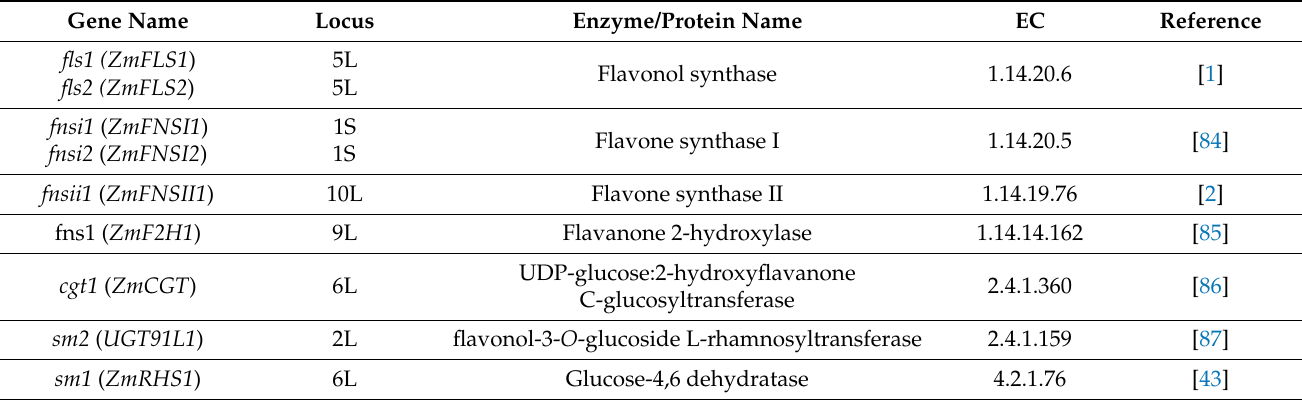
Table 3. Summary of flavonol and flavone C-glycoside genes in the maize flavonoid